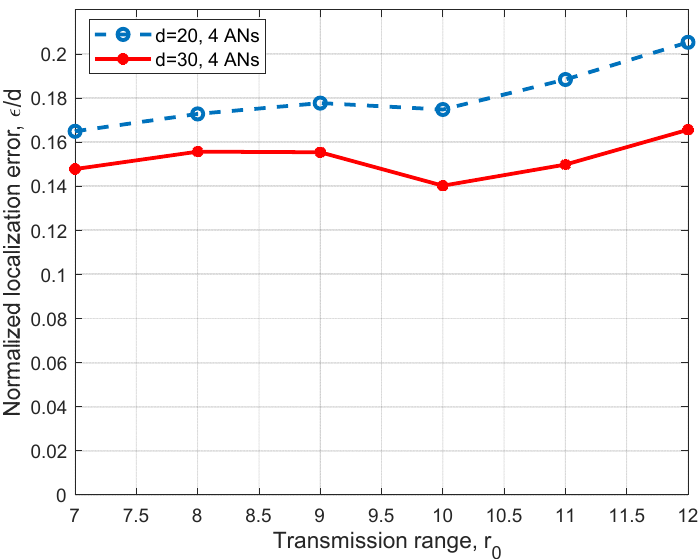
Figure 11. Error ( ε / d ) analysis for different transmission ranges, r 0 , in outdoor deployment.